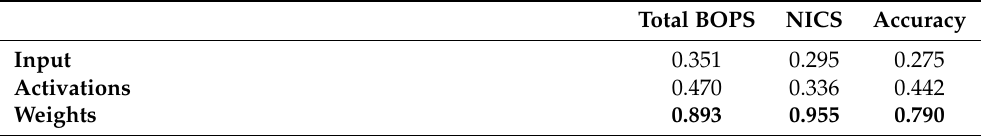
Table 2. Degree of correlation between the quantified parameters (input, activations, weights) and the total BOPS, accuracy, and NICS. The weight is the parameter with the highest